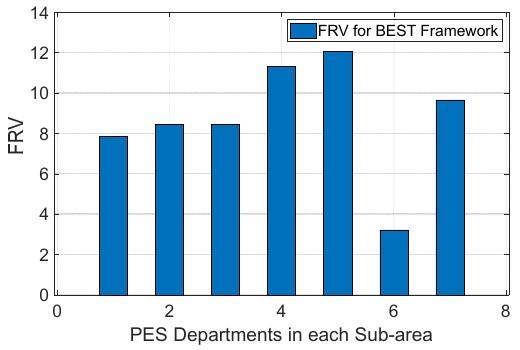
Figure 7. Evaluation of FRV for PES departments.